Question: Judging by this figure, is the value going up or going down?
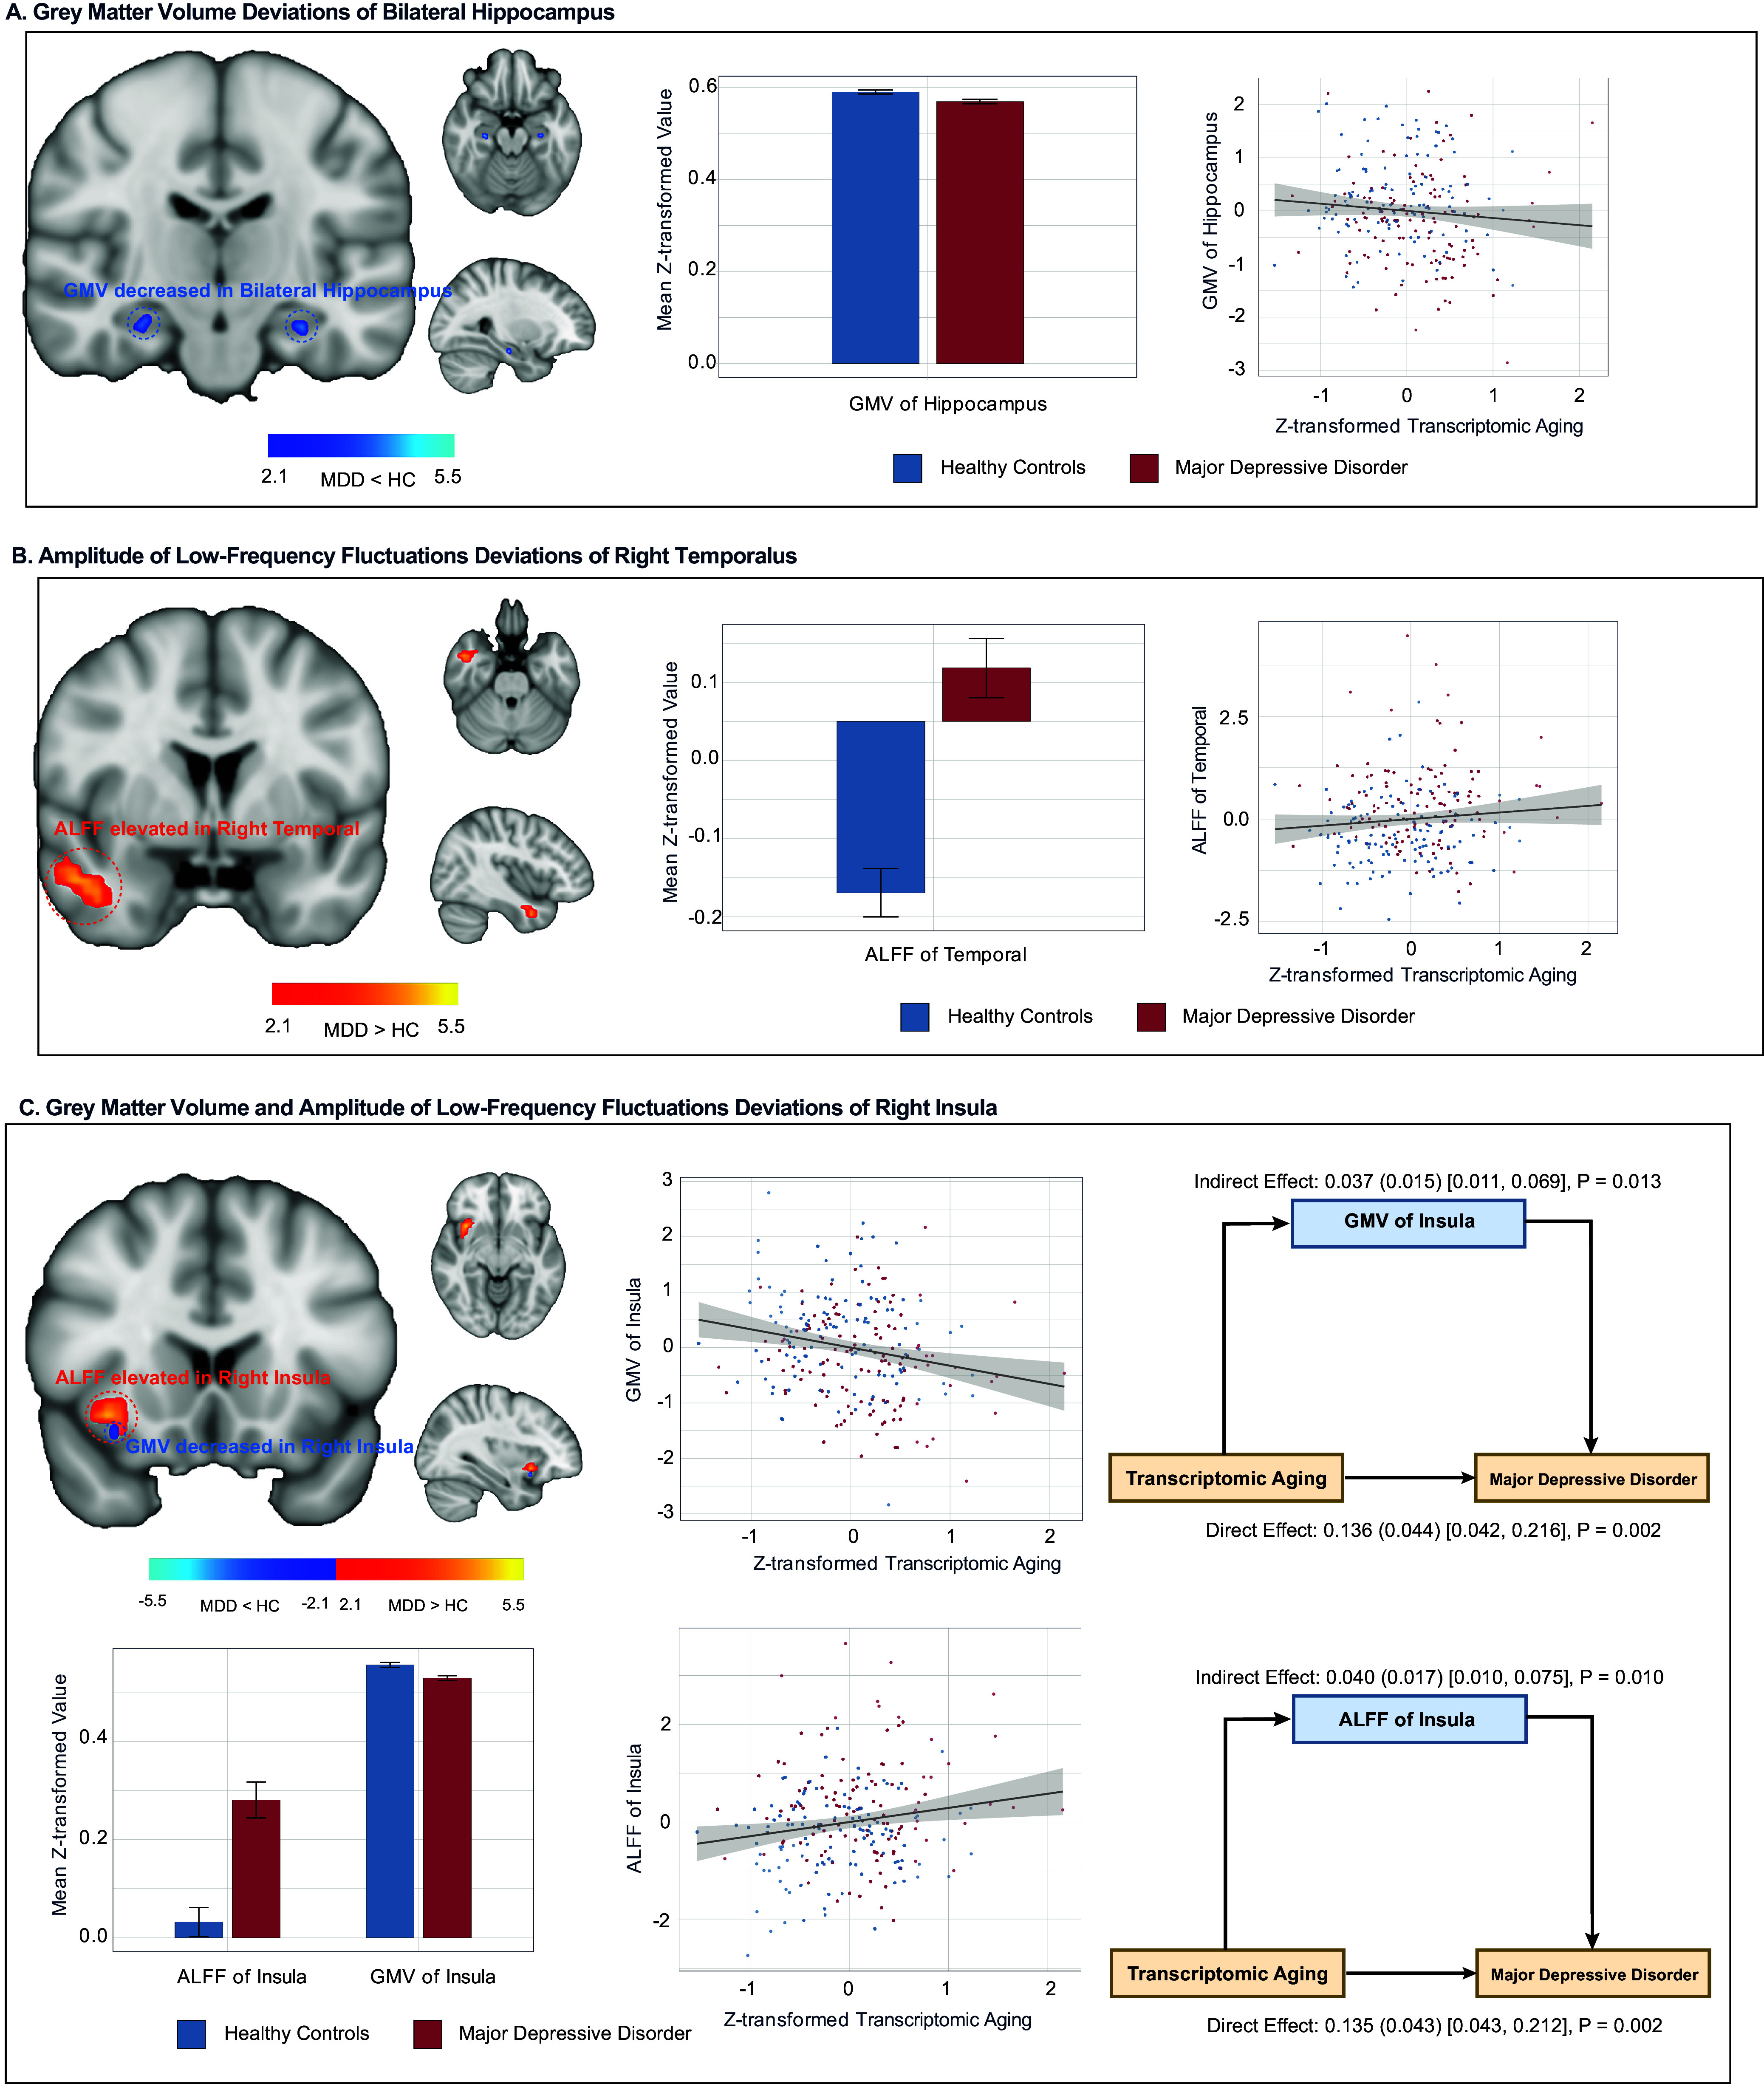
Answer: decreasing